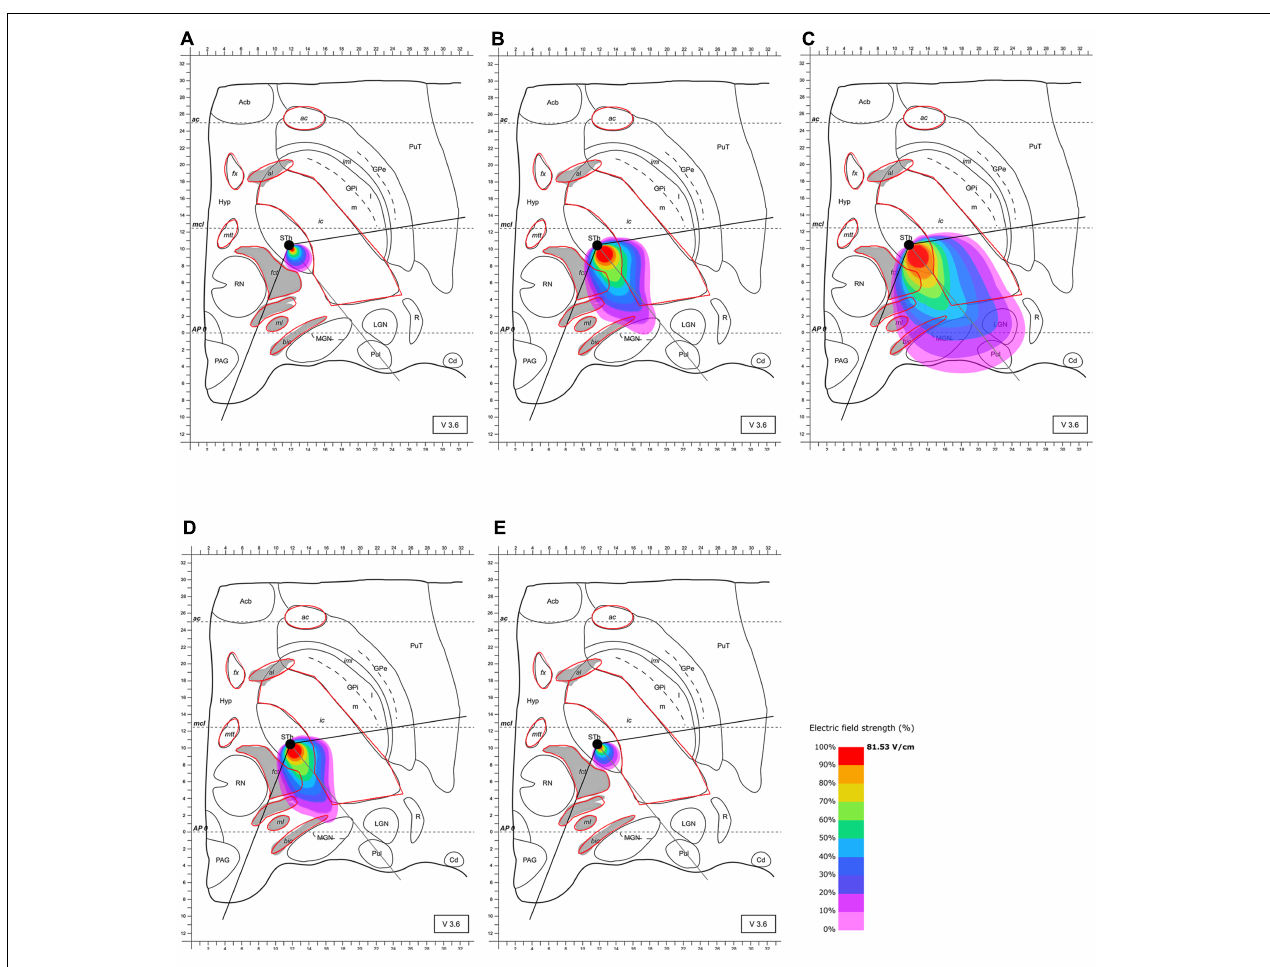
FIGURE 5 | Simulation of the electric field generated by segmented electrode stimulation through one active pole (130 Hz, 60 µ s and 2/3 mA) with the electrode lead rotated 128 ◦ counter-clockwise relative to the situation presented Figure 3 and positioned another 2 mm anterior along the AP-axis in the STN. Electric field distribution after (A) 10 µ s; (B) 40 µ s; (C) 61 µ s (maximal field extension); (D) 61.5 µ s; (E) and 62 µ s; for abbreviations see Figure 1